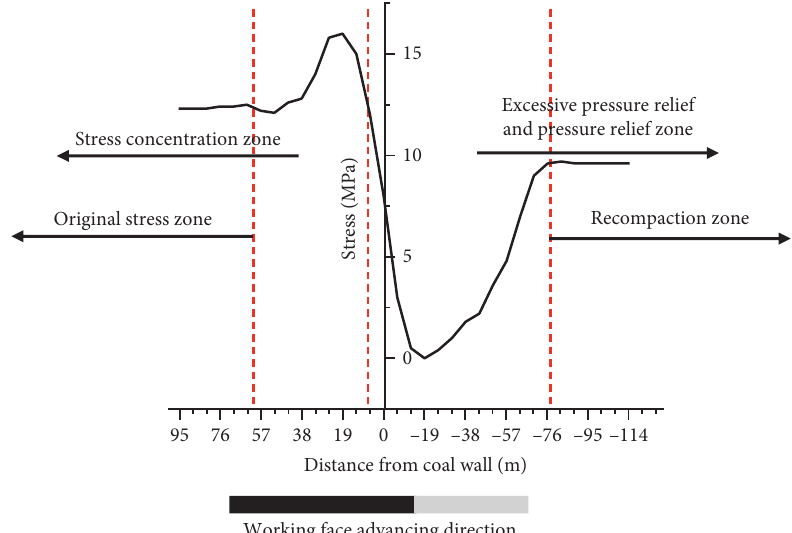
Figure 6: Stress distribution in protected coal seam 7